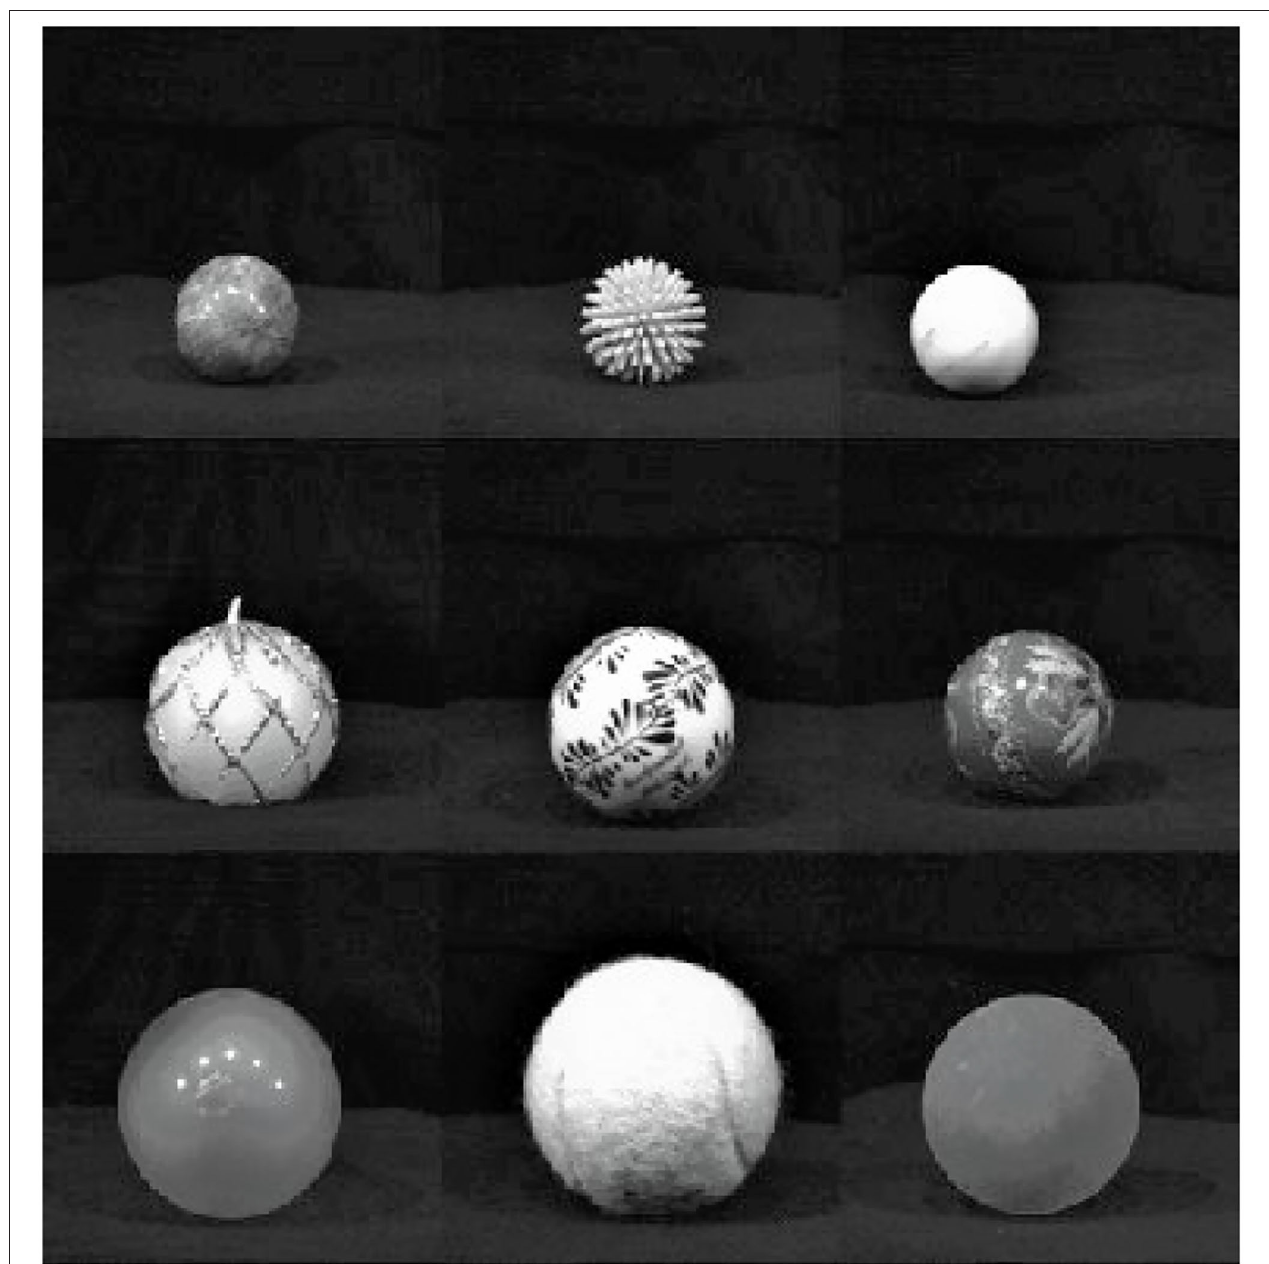
FIGURE 7 | Objects with similar shapes placed in different classes: pinch, tripod, and pronated palmar, respectively.